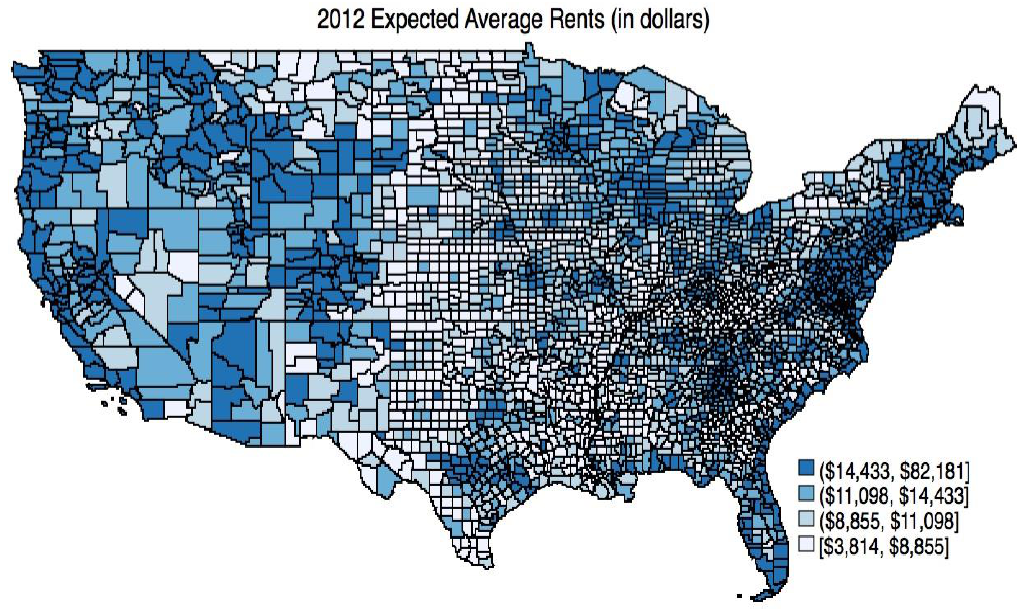
Figure 3. Expected average rents for counties in the continental United States. Source: created by the authors using STATA software.